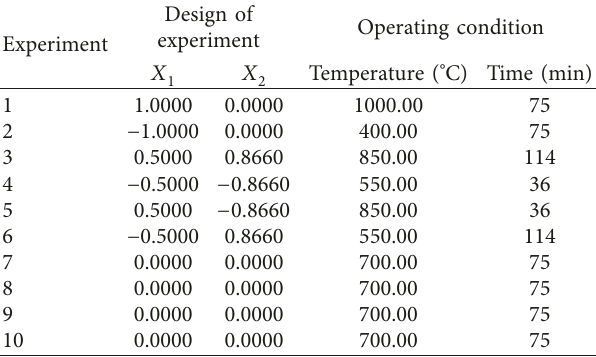
Table 2: Doehlert’s experimental design and operating